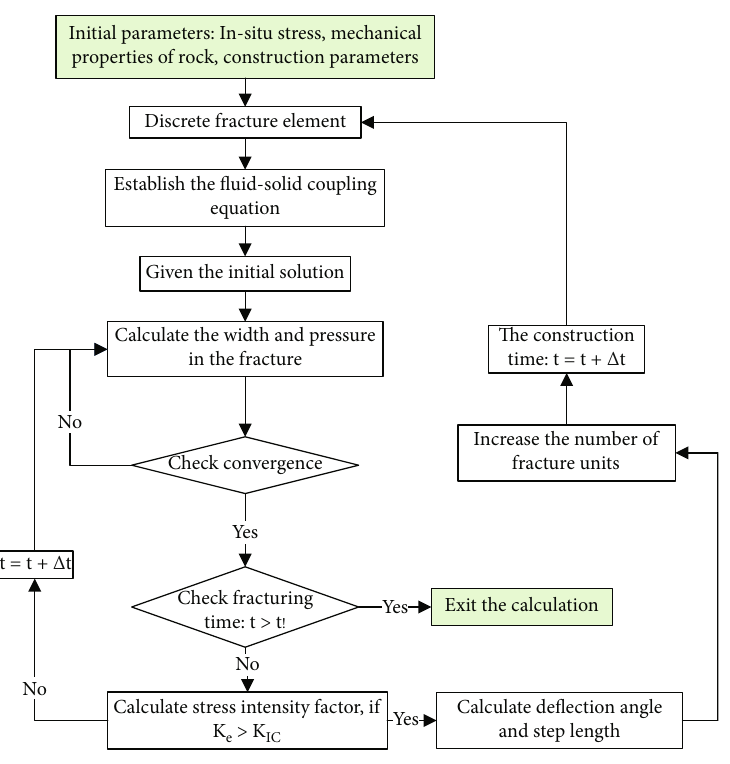
Figure 1: Computer program fl ow